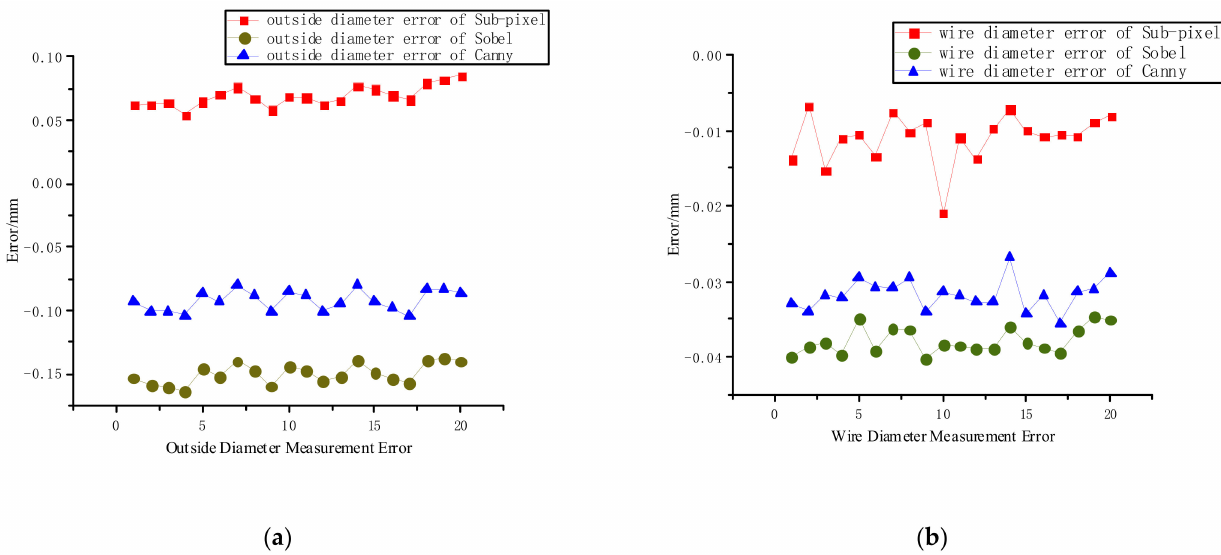
Figure 12. Error analysis chart. ( a ) Comparison chart of outside diameter measurement error; ( b ) comparison chart of wire diameter measurement